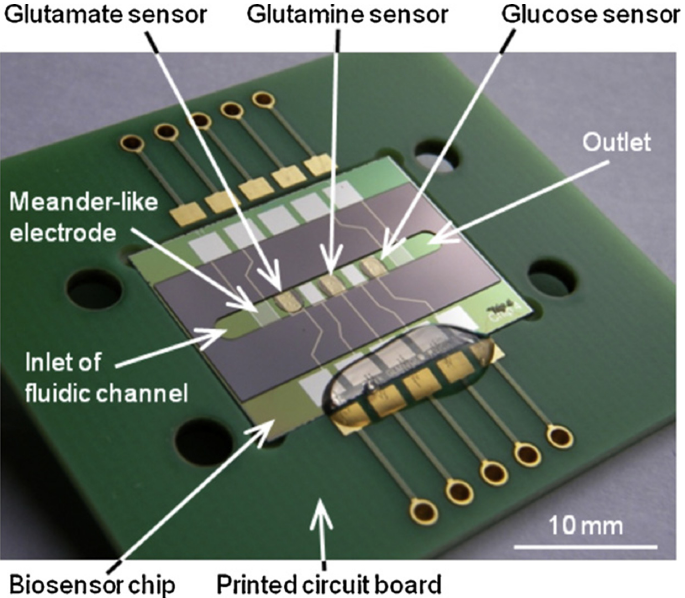
Figure 3. Photo of the biosensing chip comprising microfluidic channels and an array of amperometric enzyme sensors. The biosensor can simultaneously detect glucose, glutamate and glutamine, while the meander-like electrodes can detect temperature. Reprinted from [291]. Copyright (2020), with permission from Elsevier.